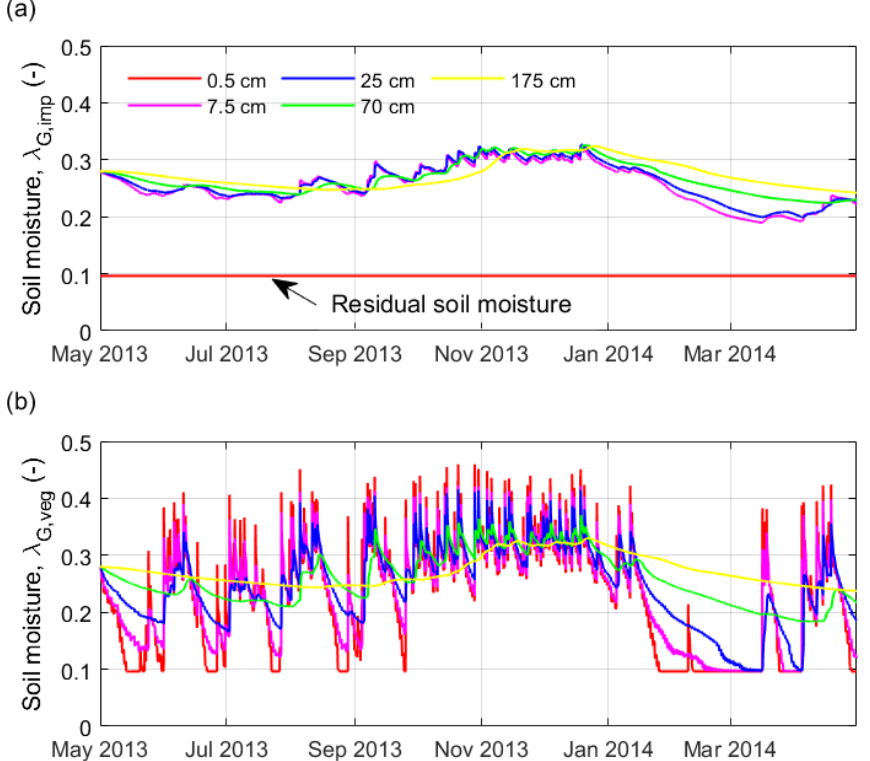
Figure 10. Simulated soil moisture in soil columns underneath impervious ground cover (a) and vegetation (b) at 0.5, 7.5, 25, 70, and 175cm depth at Telok Kurau, Singapore. Residual water content is 0.096 (–) and saturated water content is 0.460 (–). As the top soil layer of the impervious ground cover is fully sealed, it is displayed here with the residual soil moisture. The time series includes one unusually dry period from mid-January to mid-March